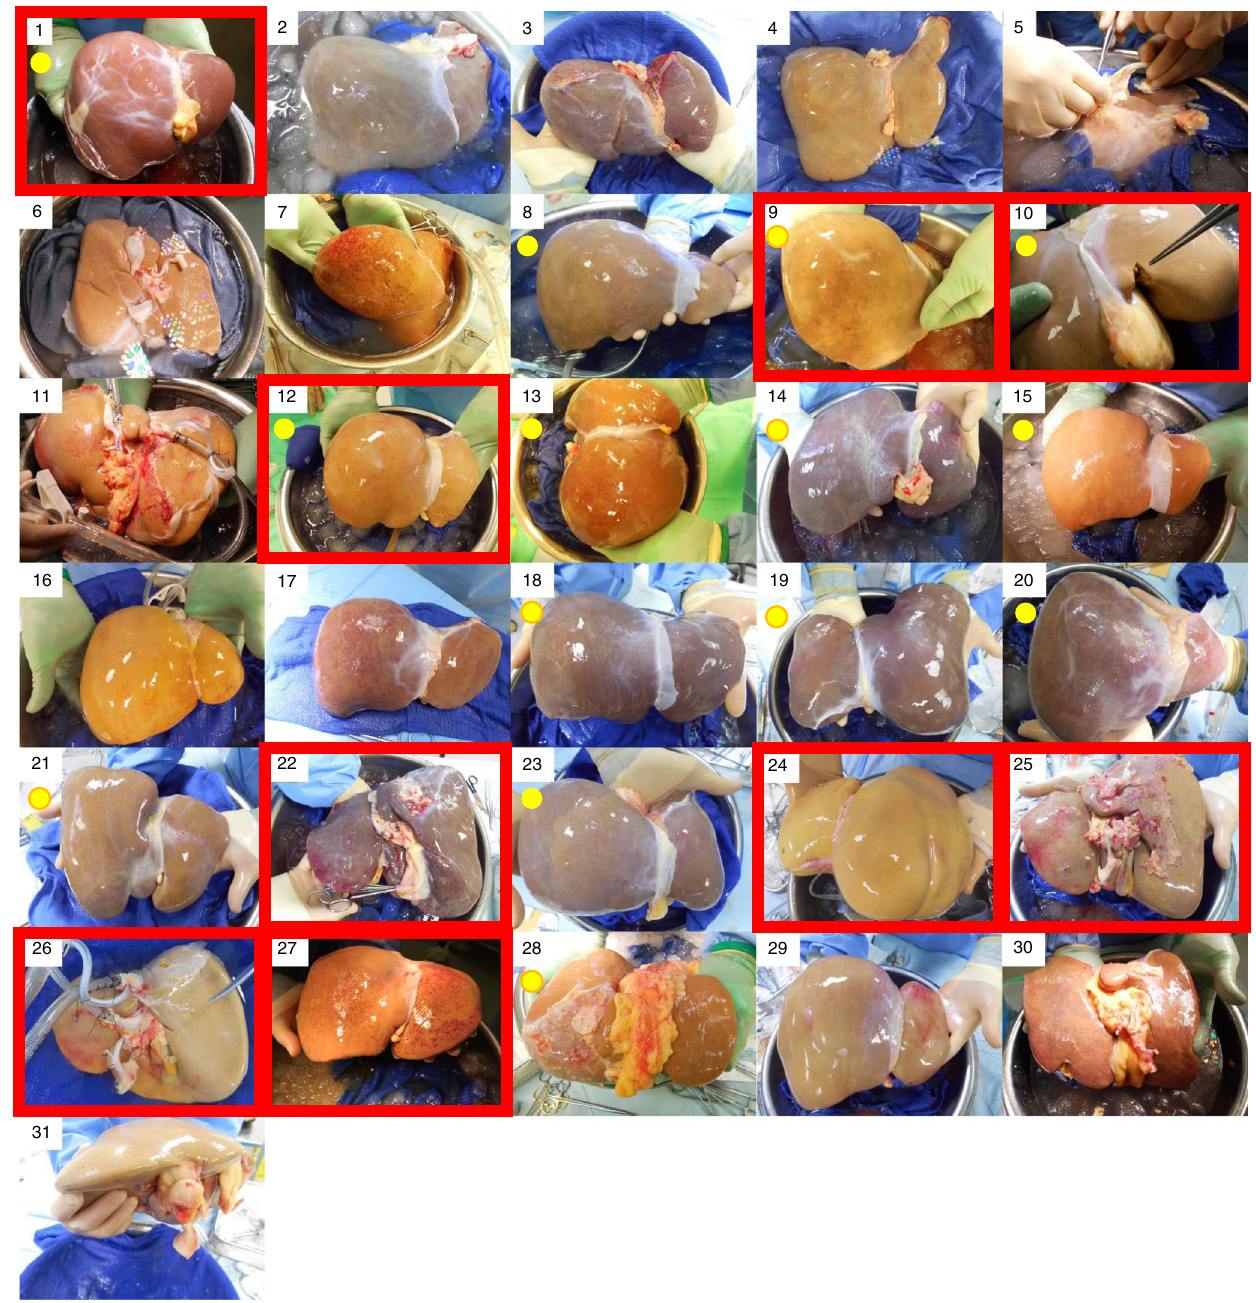
Fig. 3 The study liver photographs. The fi gure shows all 31 livers included in the trial. The red frames designate non-transplanted organs and the yellow dot livers donated after circulatory